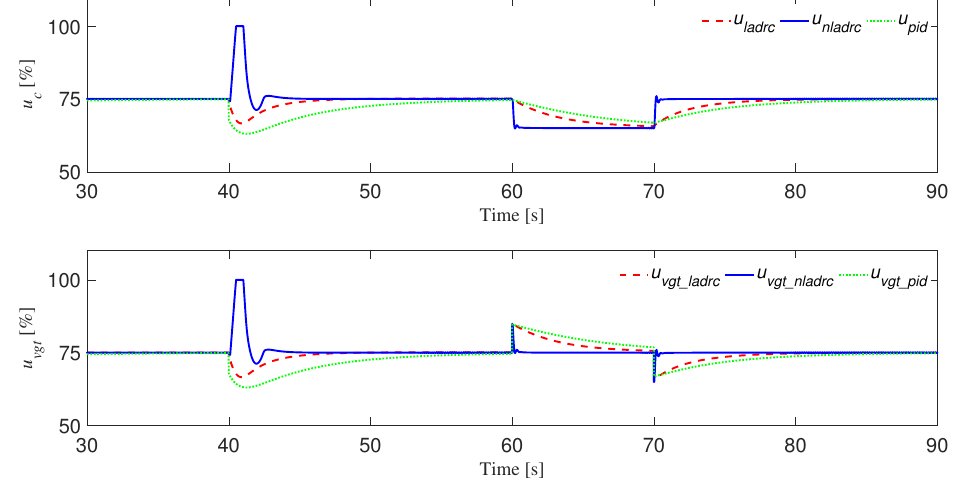
Figure 8. Output signal u c of controller and input signal u vgt of VGT valve.